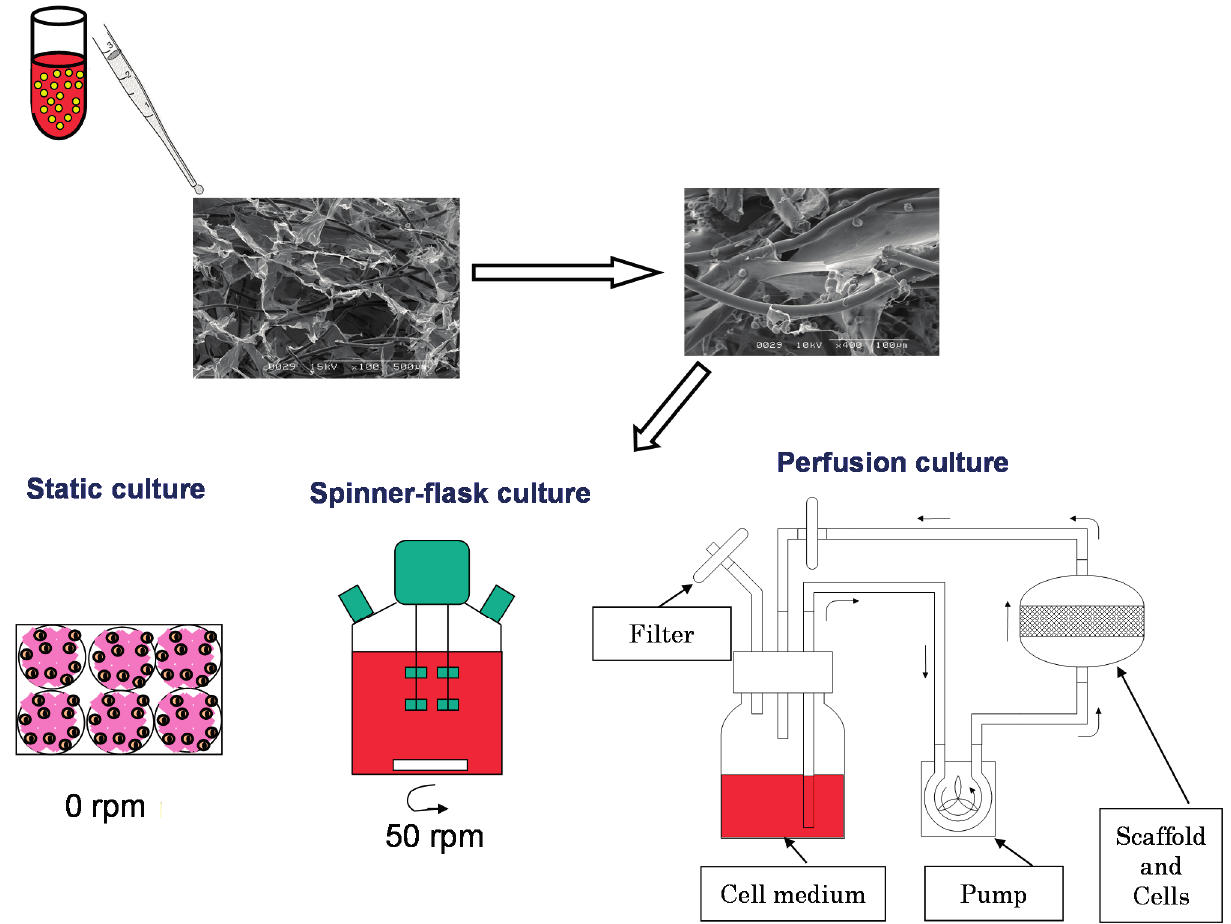
Figure 5. Principal of in vitro cell culture on 3D scaffolds in static, spinner-flask and perfusion